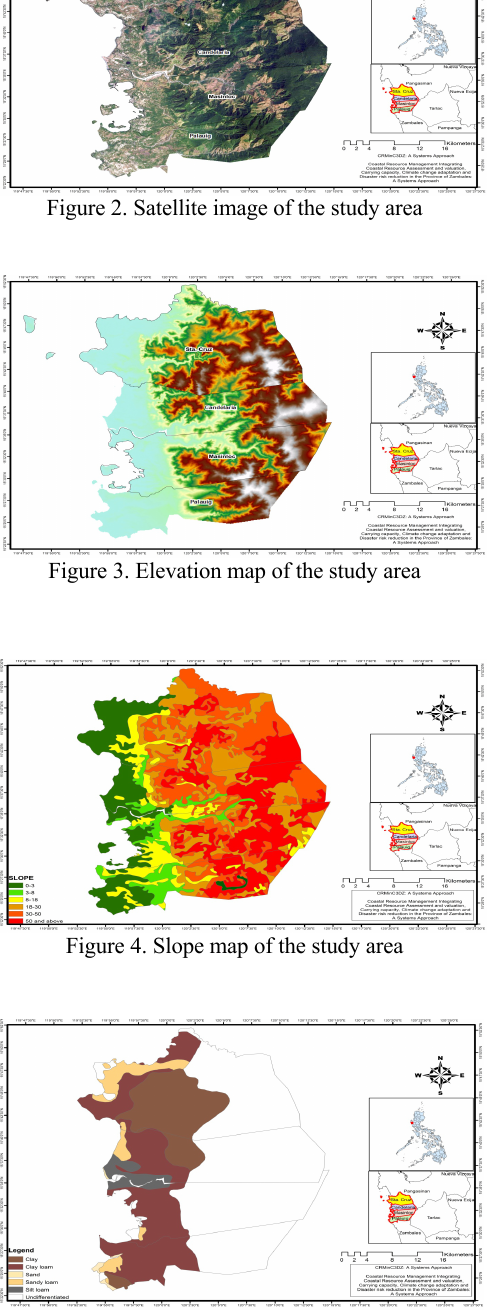
Figure 5. Soil map of the study